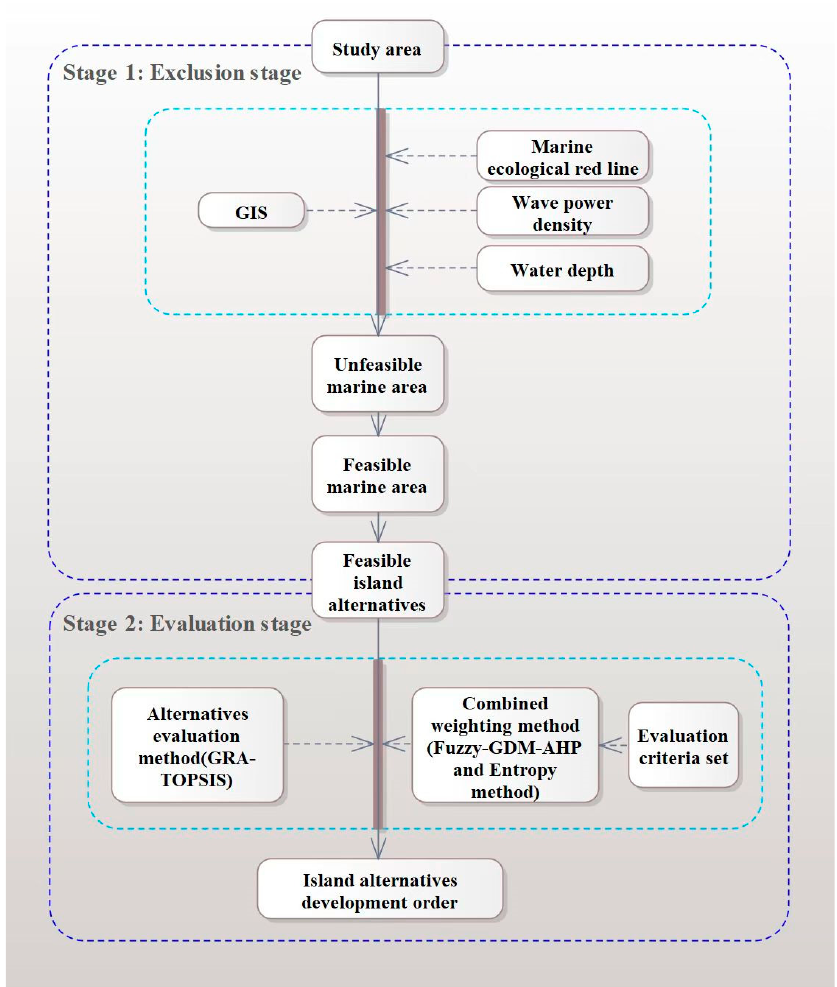
Figure 1. Decision-making framework for site selection.